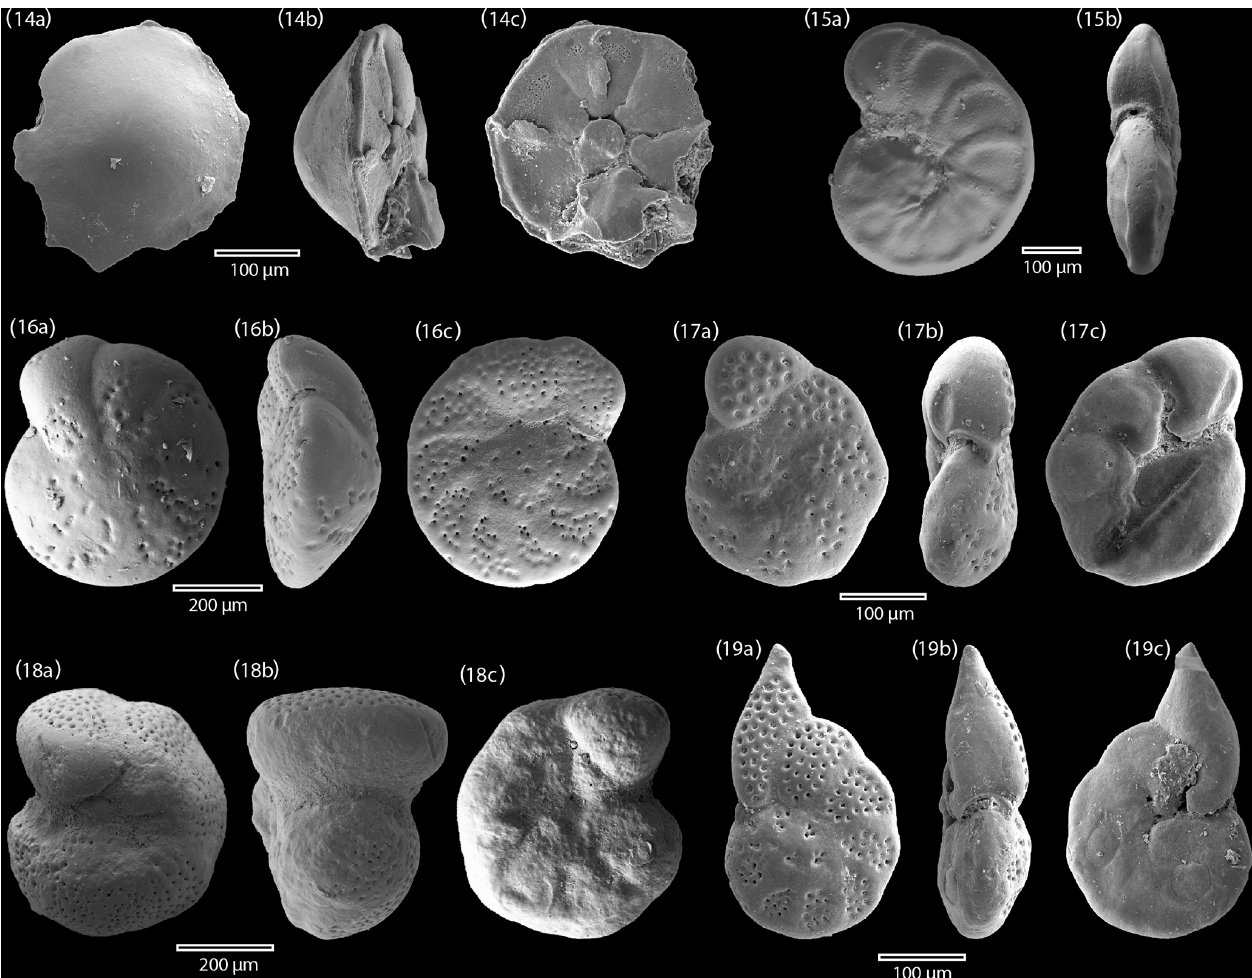
Figure 9. Scanning electron microscope (SEM) images of characteristic benthic foraminifera from core MD13-3462G. (1)